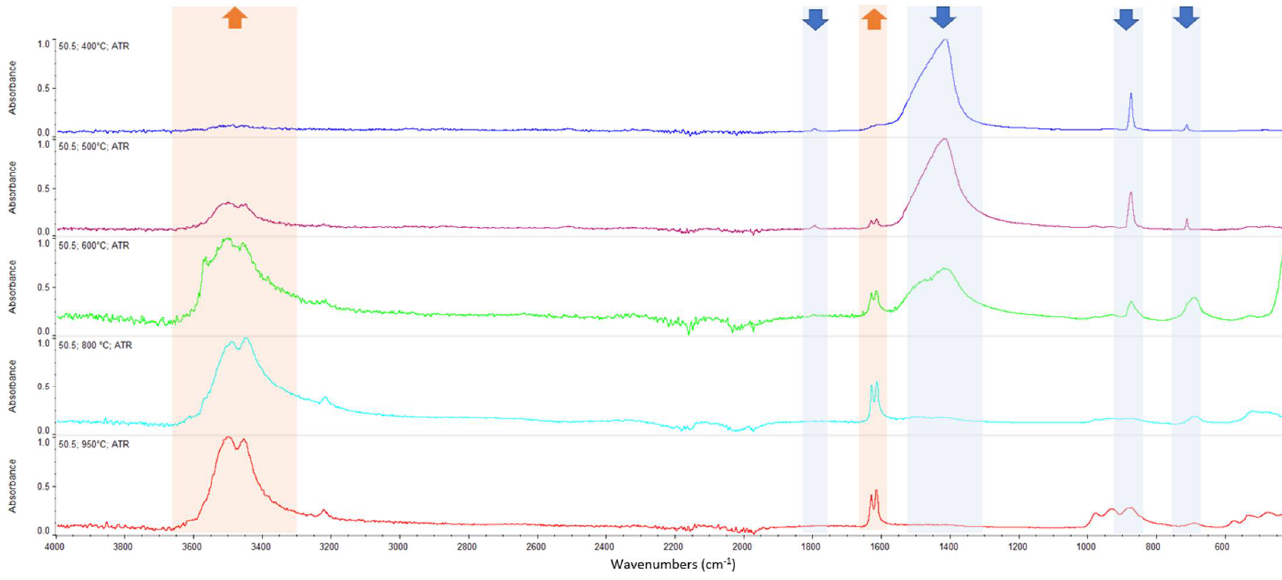
Figure A5. FTIR spectra of ashes of F50.4 at 950 °C (red), at 800 °C (light blue), at 600 °C (green), at 500 °C (purple), at 400 °C (blue).